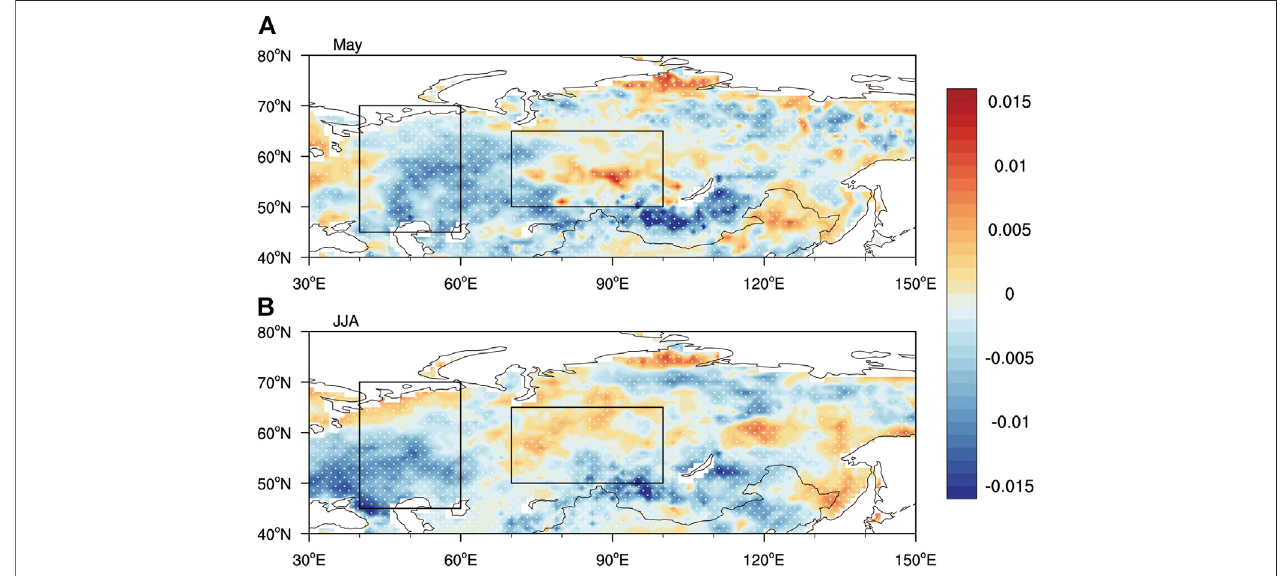
FIGURE3 |(A) May and (B) summer(JJA) 0 – 7-cm soil moisture anomalies (m 3 m − 3 ) regressed onto theSSDI.The black rectangles are thesameasin Figure 1A , and the stippling indicates the regression coef fi cients statistically signi fi cant at the 95% con fi dence